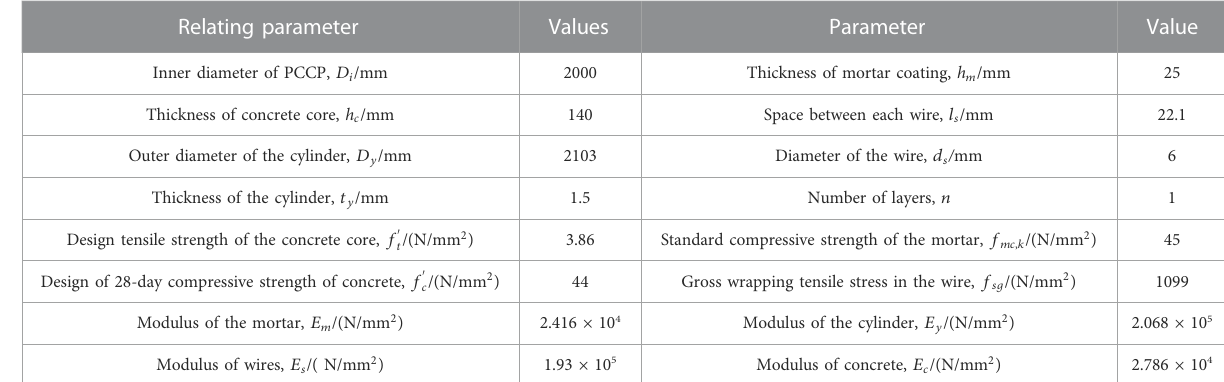
TABLE 1 Major parameters of the